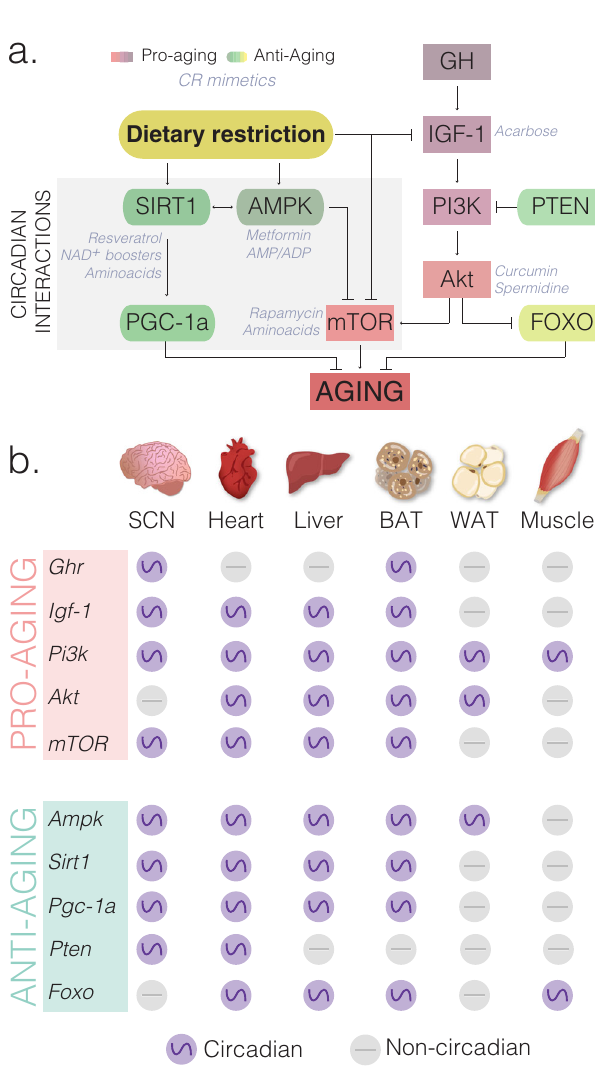
Fig. 2 Aging-related pathways regulated by dietary interventions display circadian oscillations. a Dietary interventions in fl uence nutrient-sensing pathways 50 by inducing antiaging (yellow-green gradient) and reducing proaging (pink-purple gradient) molecules. There are known direct interactions between nutrient-sensing pathways involve in aging (SIRT1, AMPK, NAMPT, mTOR) and core clock genes (CLOCK/BMAL and PER/CRY). Several compounds known as caloric restriction mimetics (CRM, shown as gray font color) target speci fi c nutrient-sensing genes and mimic the health bene fi ts of CR without reducing food intake. CRMs tested by ITP and other laboratories include acarbose, curcumin, spermidine, rapamycin, metformin, resveratrol, NAD + boosters and amino acids (reviewed by ref. 172 ). CRMs (gray font color) are indicated next to or below their molecular targets. b Aging-related genes are expressed in a circadian manner (purple circles) in at least one tissue. Genes that are noncircadian in each tissue are represented as gray circles. RNA-seq and microarray containing circadian datasets for liver 16 and other tissues extracted from CircaDB (http://circadb.hogeneschlab.org, Hogenesch laboratory). Proaging molecules: GH (growth hormone), GHR (growth hormone receptor), IGF-1 (insulin-like growth factor 1), PI3K (Phosphoinositide 3-kinase), AKT (also known as Protein kinase B), and mTOR (Mechanistic or Mammalian target of rapamycin). Antiaging molecules: SIRT1 (Sirtuin 1), AMPK (5 ’ AMP- activated protein kinase), PGC-1 α (PPAR γ co-activator 1a), PTEN (Phosphatase and tensin homolog), FOXO (Forkhead Box O). Core clock components CLOCK/BMAL1 (transcriptional activators) and PER/CRY (transcriptional repressors). See also Supplementary Table 1 for additional tissues and aging- related genes in mouse, baboon, and